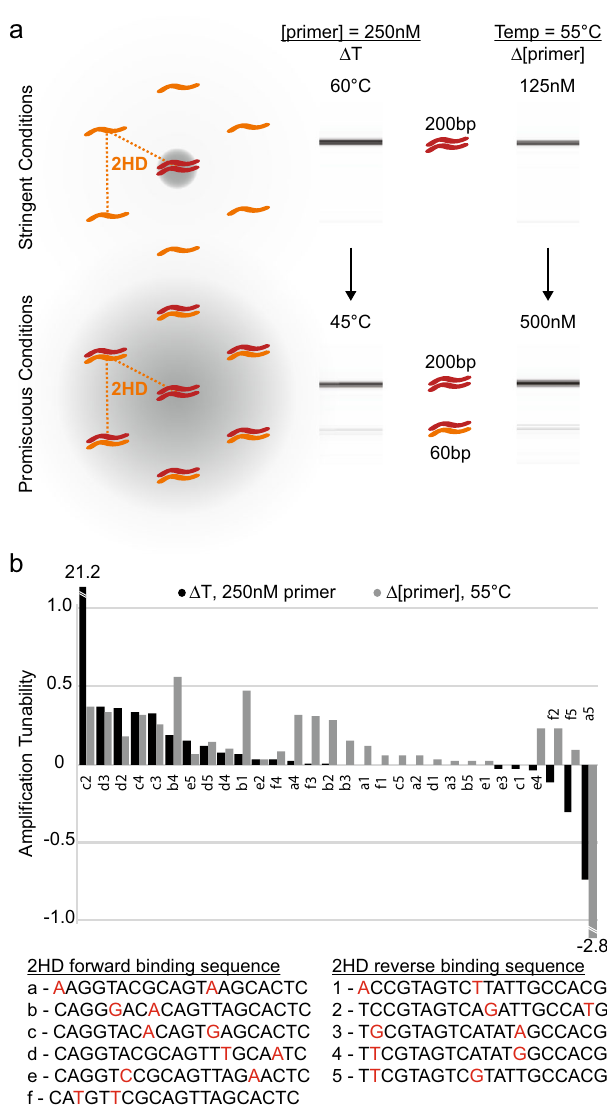
Fig. 2 Thermodynamic tuning of ampli fi cation within competitive PCRs. a Strands with 2 HD binding sites (60bp, orange) are screened for nonspeci fi c ampli fi cation in a competitive reaction against 0 HD strands (200bp, red). Two stringent conditions are individually tested (top row): (left) 250nM primer at 60°C and (right) 125nM at 55°C. The promiscuous conditions individually tested (bottom row) are (left) 250nM primer at 45°C and (right) 500nM at 55°C. Gray spheres encompass strands that are expected to be ampli fi ed, and the gel electrophoresis lanes show experimental results. b A screen of a library of sequences is conducted to fi nd sequences to be used in scaling to full fi les and databases. Each forward binding sequence (letters a – f) is paired with every reverse binding sequence (numbers 1 – 5) in the reactions described in a . Ampli fi cation tunability is de fi ned as the difference in the ratio of mismatch (60bp) strands to perfect match (200bp) strands from promiscuous to stringent conditions. Positive values represent tunability in the expected direction. Tunability using annealing temperature (black) and primer concentration (gray) are shown. Source data are provided as a Source Data fi